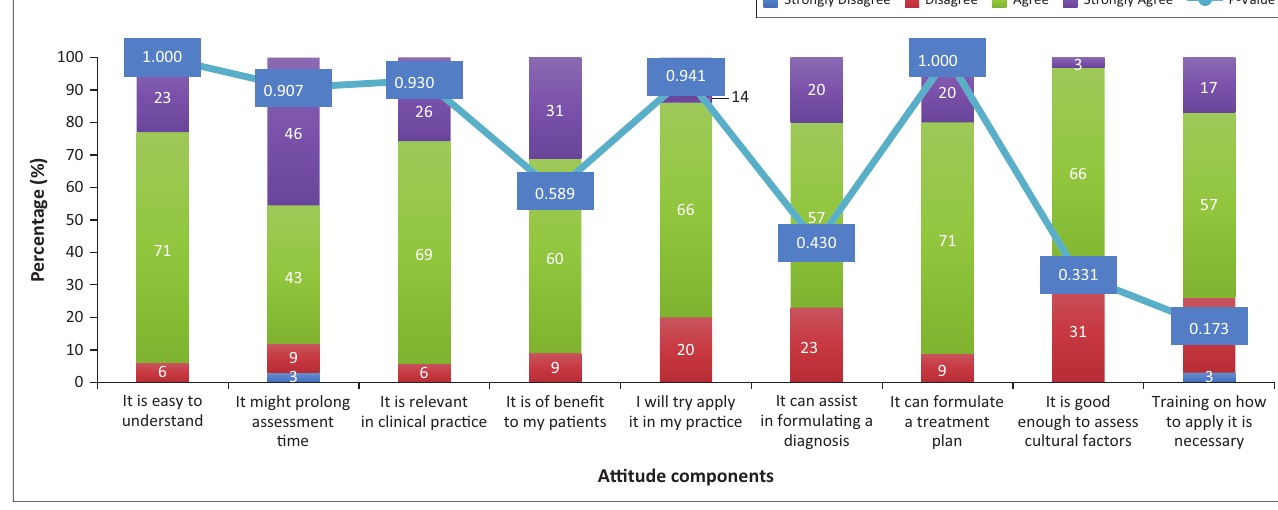
FIG URE 1: Associations between awareness and attitude components.